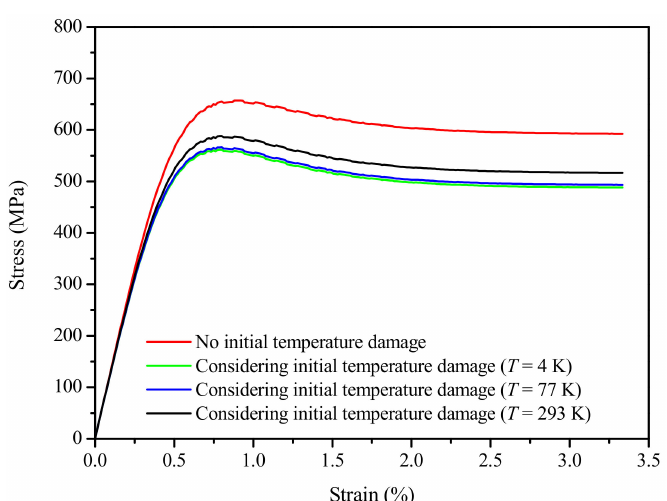
Figure 7. Stress–strain curve of EAS-Nb 3 Sn fiber with initial thermal